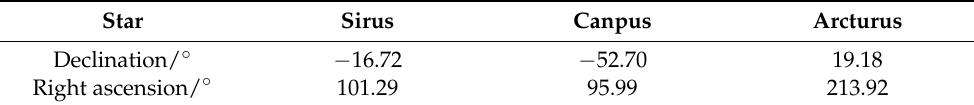
Figure 5. Profile of PSR B1821-24. Table 3. Reference stars